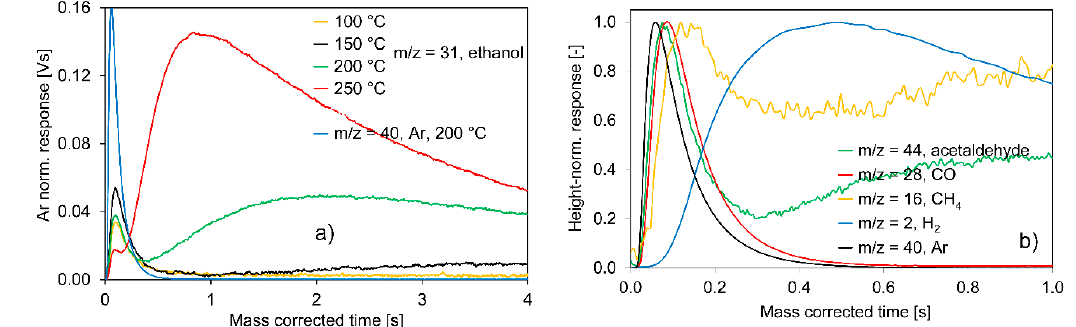
Figure 9. ( a ) Ar-normalized transient responses to pulses of 34.6 vol % ethanol in Ar at temperatures between 100 °C and 250 °C on the H 2 pre-reduced Ir/C catalyst (20 mg) at an m/z-value of 31 for ethanol; response pulse of Ar (m/z-value of 40) at 200 °C for comparison. ( b ) Height-normalized transient responses to pulses of 34.6 vol % ethanol in Ar at m/z-values of 2 for H 2 , 16 for CH 4 , 28 for CO, 44 for acetaldehyde and 40 for Ar on the H 2 pre-reduced Ir/C catalyst (20 mg), T = 200 °C.